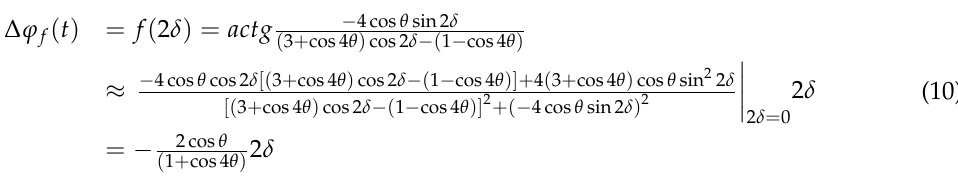
Figure 4. The nonlinearity factor of the OVS system with θ varying 160 ~ 200°.